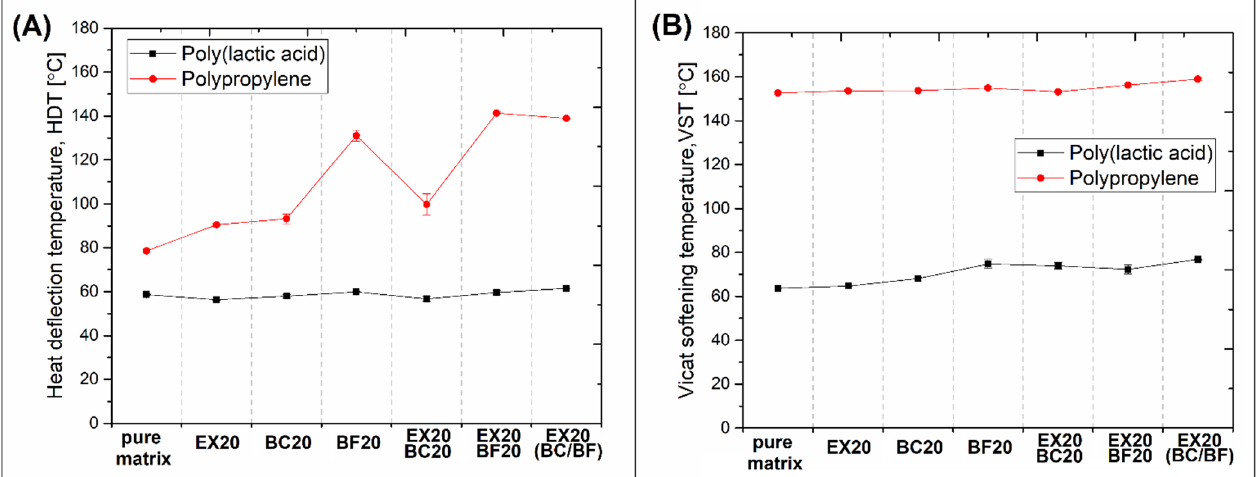
Figure 9. The results of ( A ) HDT and ( B ) VST measurements of all PLA and PP-based samples.